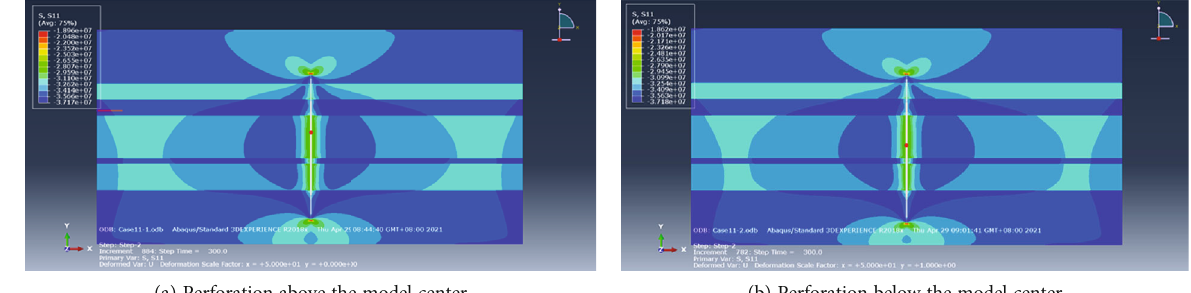
Figure 20: The in fl uence of the perforation position on height growth.